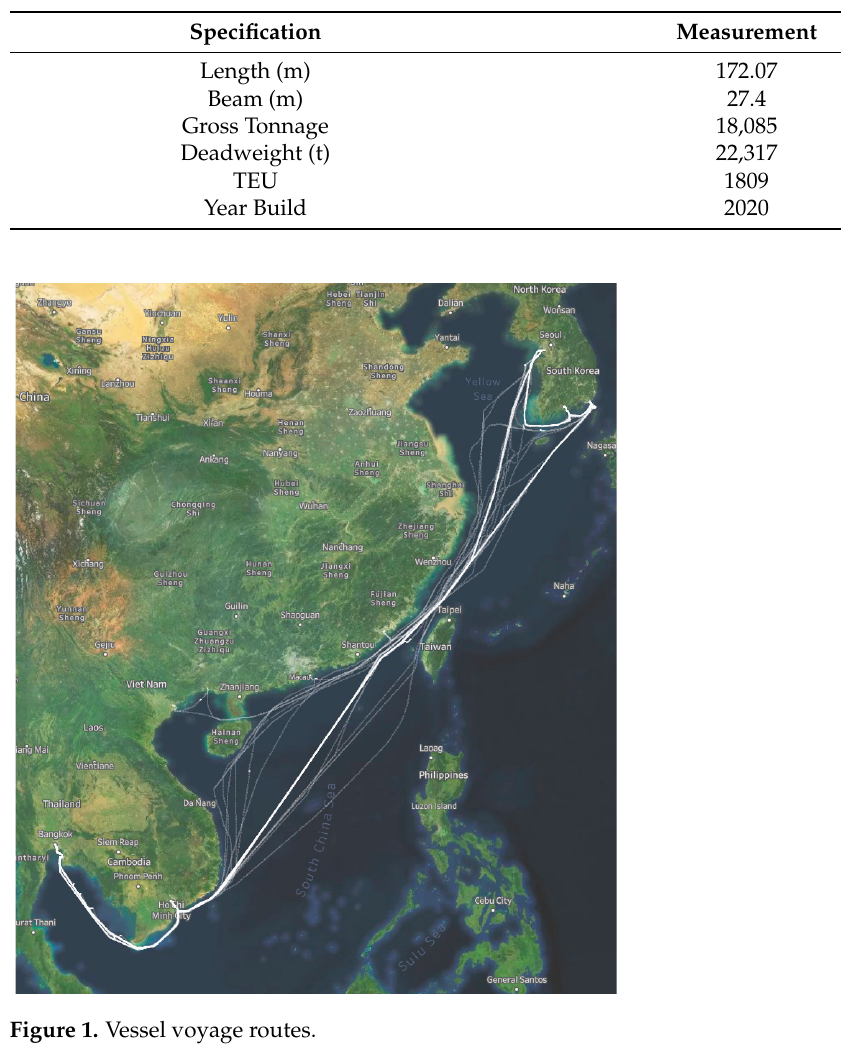
Table 1. Vessel specifications.